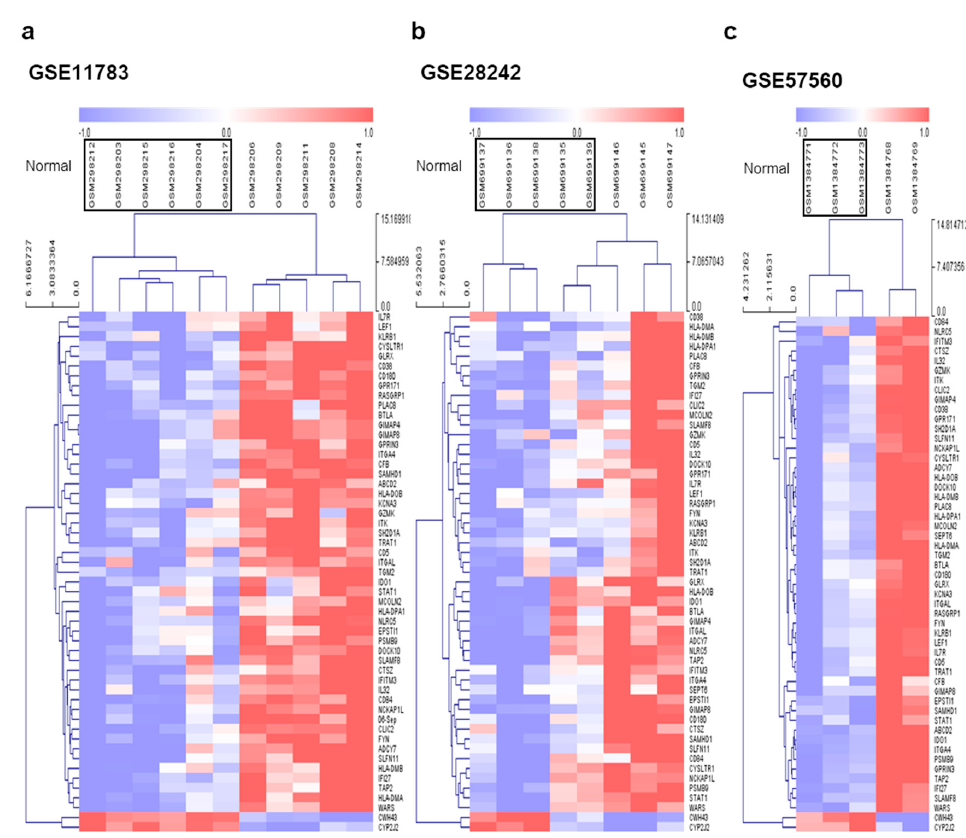
Figure 3. Expression of common differentially expressed genes (DEGs) in IC/BPS datasets. The heatmap represents the expression and tendency of intersected genes in each dataset. These data were analyzed by hierarchical clustering using the MeV software. The color of the pattern depends on the level of gene expression with a threshold of − 1 < z-score < 1, where the high and low values outside of the criteria were assigned the highest and lowest values. ( a ) GSE11783, ( b ) GSE28242, and ( c ) GSE57560 are shown.